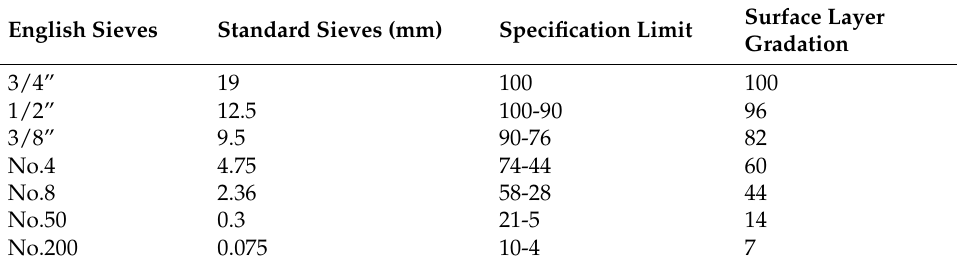
Table 3. Aggregate gradation of a surface layer.